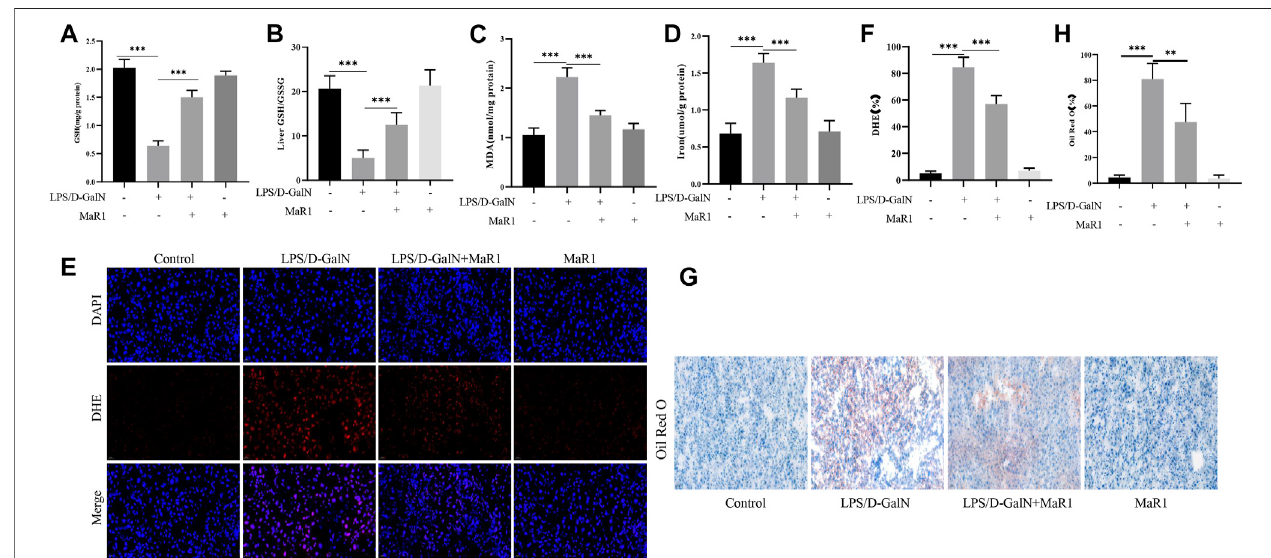
FIGURE3| MaR1inhibitedD-GalN/LPS-inducedliverlipidperoxidationinmice. (A) D-GalN/LPSsigni fi cantlyreducedtheGSHcontent,andthetreatmentofMaR1 signi fi cantlyincreasedtheGSH content. (B) MaR1signi fi cantlyincreasedtheGSH/GSSG inlivertissue. (C) D-GalN/LPS signi fi cantlyincreasedtheserum MDAcontent, while MaR1 signi fi cantly decreased the level of MDA. (D) Serum iron content signi fi cantly reduced after mice treated with MaR1. (E,F) MaR1 ef fi ciently reversed the increase of ROS level. (G,H) Oil Red O staining showed that MaR1 signi fi cantly decreased the lipid accumulation in the liver with D-GalN/LPS treatment. Data are shown as the mean ± SD, * p < 0.05; ** p < 0.01; *** p < 0.001.